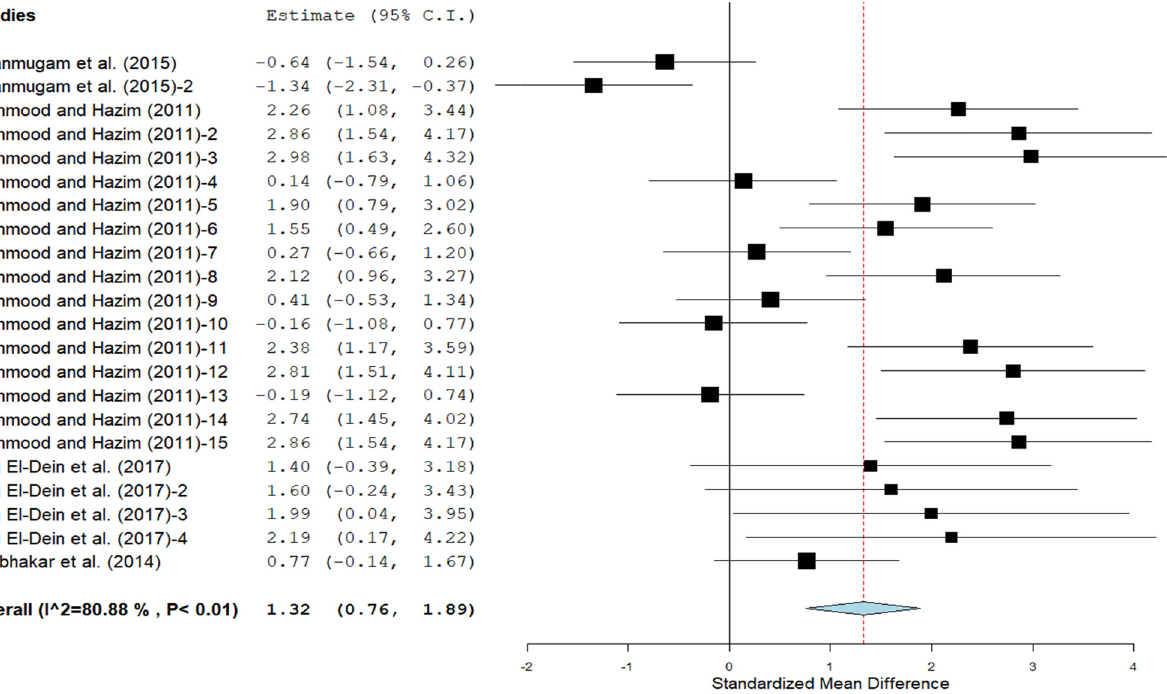
Figure 2: Impact of dietary zinc additive on semen output. The thick vertical line is the line of no e ff ect ( i.e. SMD = 0 ) . Points to the left of this thick vertical line connote a decrease in semen output, while points to the right depict an increase in semen output. The dotted line shows the overall SMD. The result is considered signi fi cant the 95% CI of the overall SMD did not include